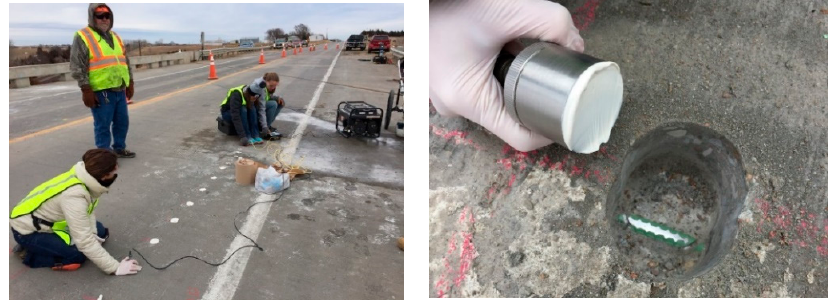
Figure 20. Images from pilot field work.